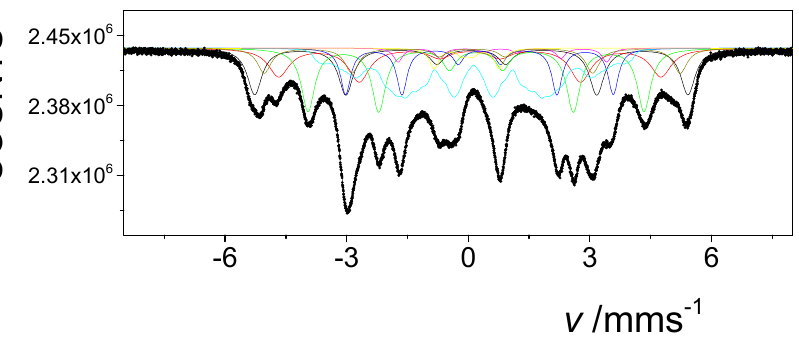
Figure 3. Room temperature 57 Fe Mössbauer spectrum of non-irradiated FINEMET sample of CK022, recorded with the high velocity resolution Mössbauer spectrometer in 4096 channels in transmission geometry.